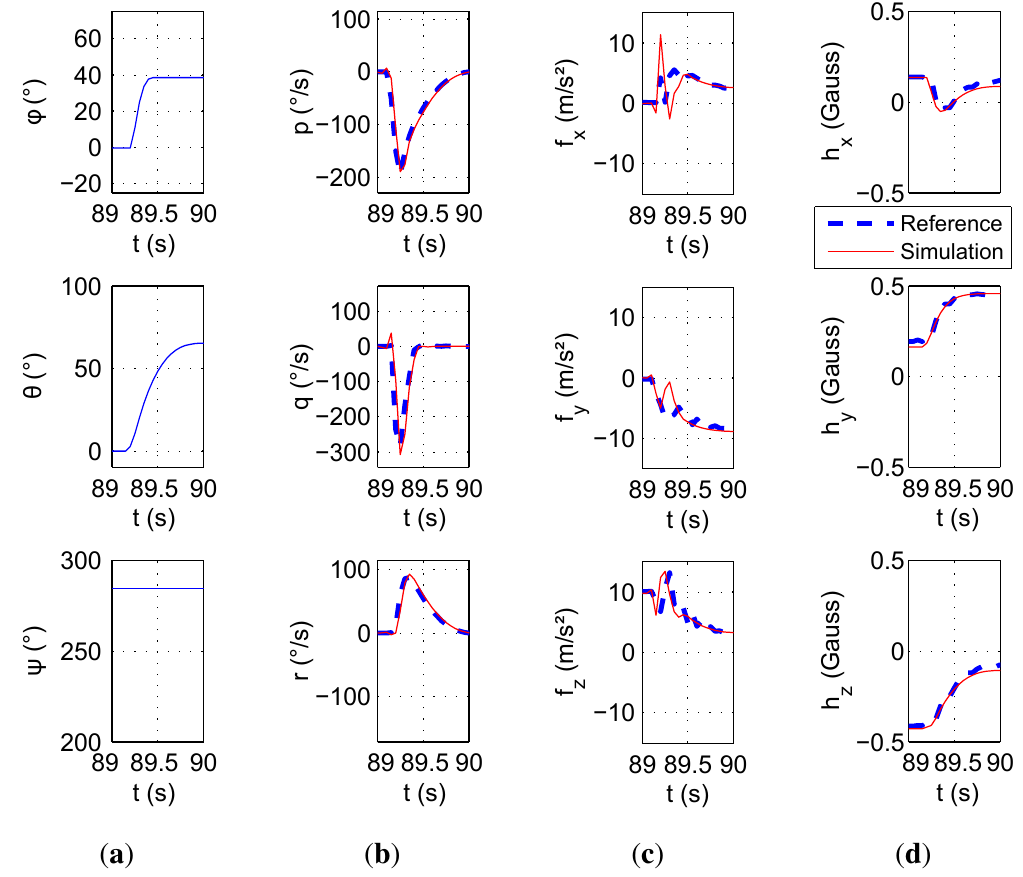
Figure 7. Simulation of a fast motion. ( a ) Euler angles; ( b ) angle rates; ( c ) specific force; ( d ) magnetic